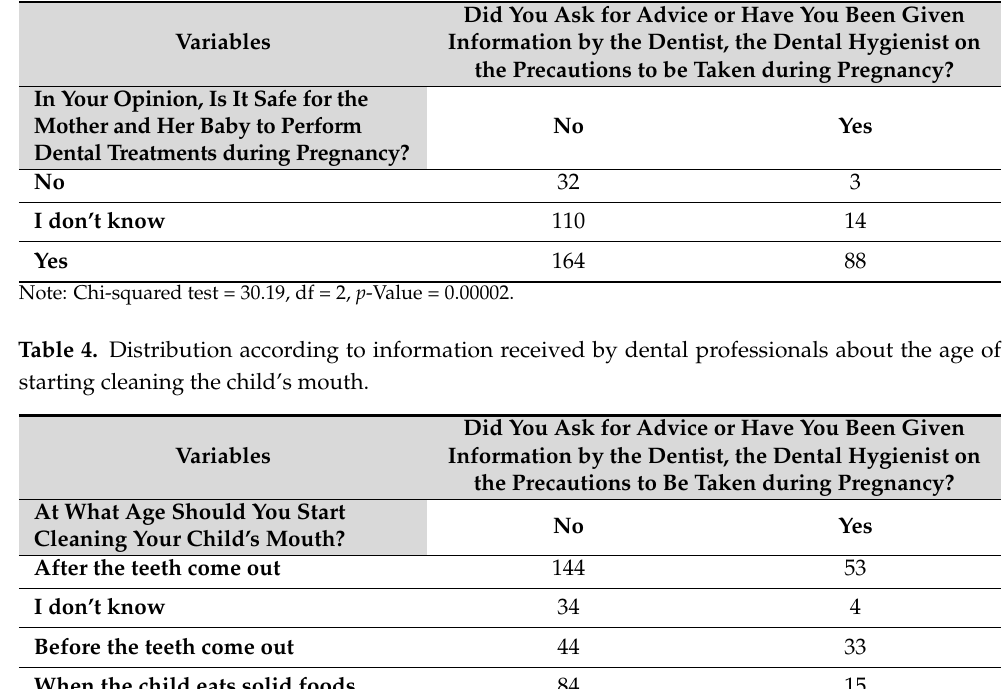
Table 3. Distribution according to information received by dental professionals about safety of performing dental treatments.